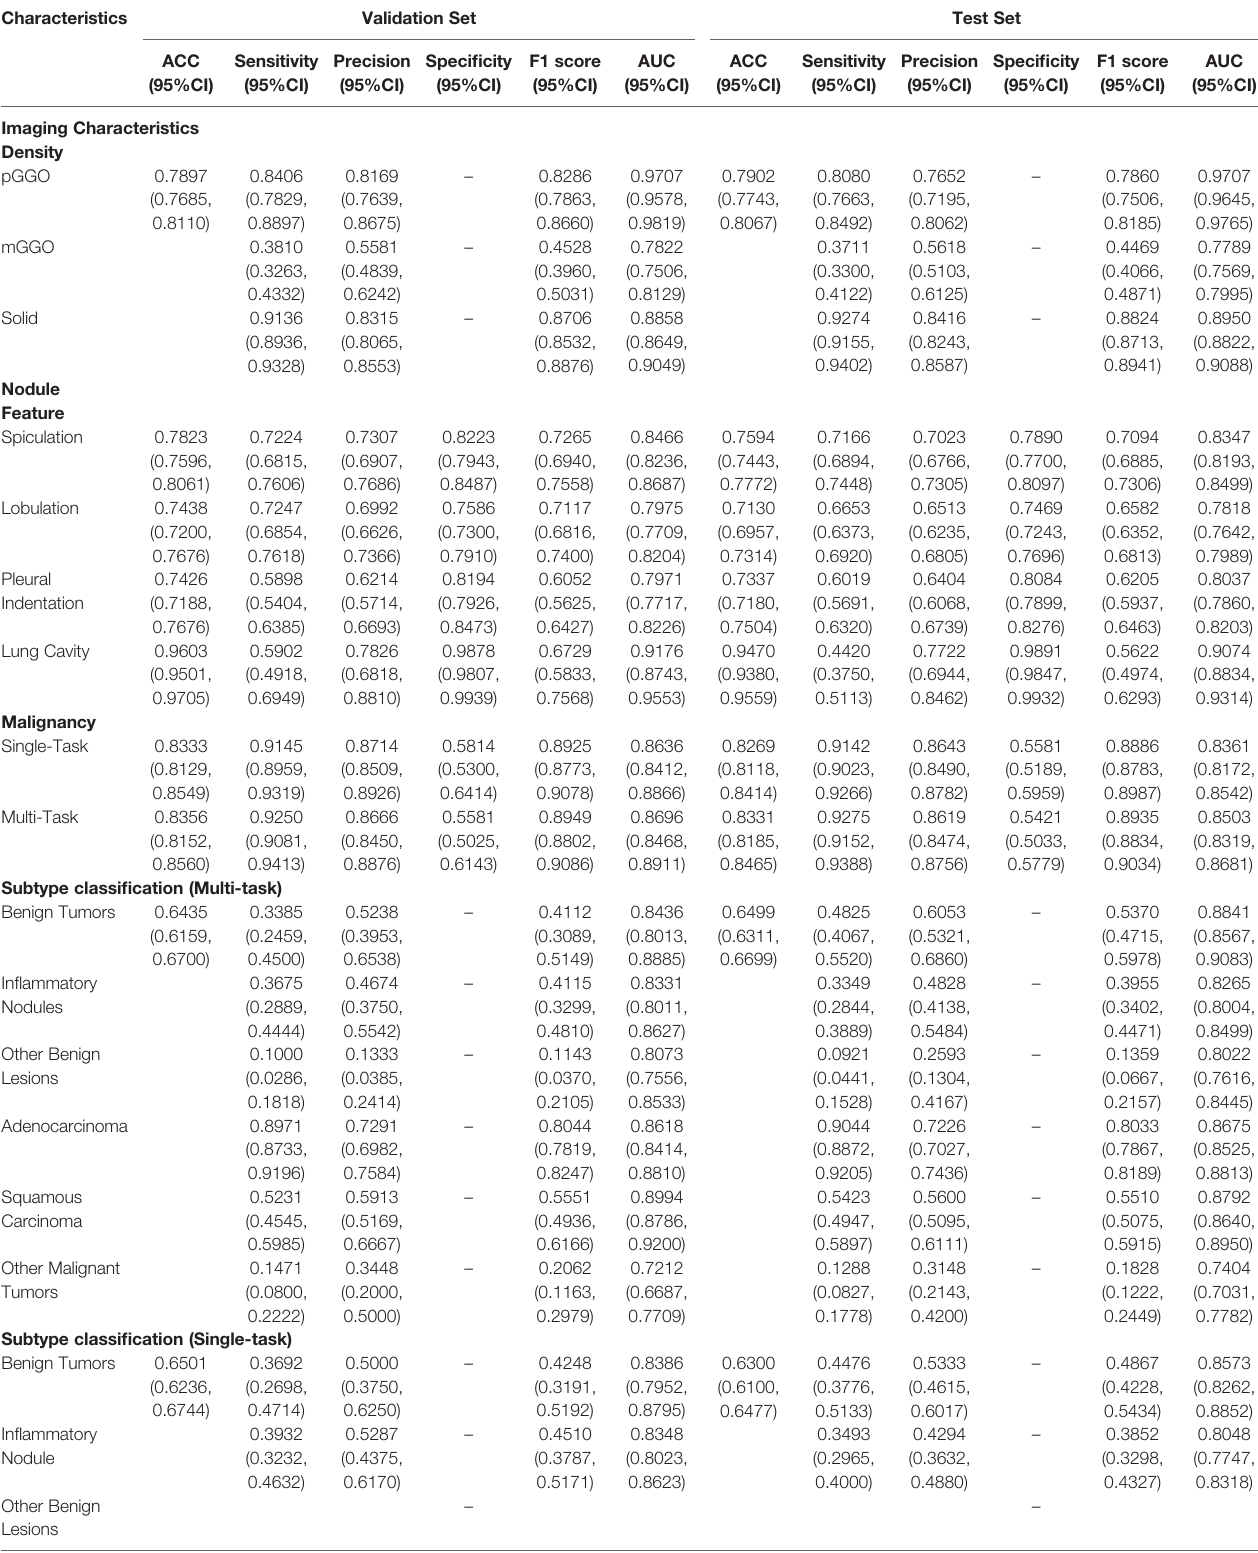
TABLE 2 | Performance of DeepLN to predict the imaging characteristics, malignancy, and pathological subtypes.